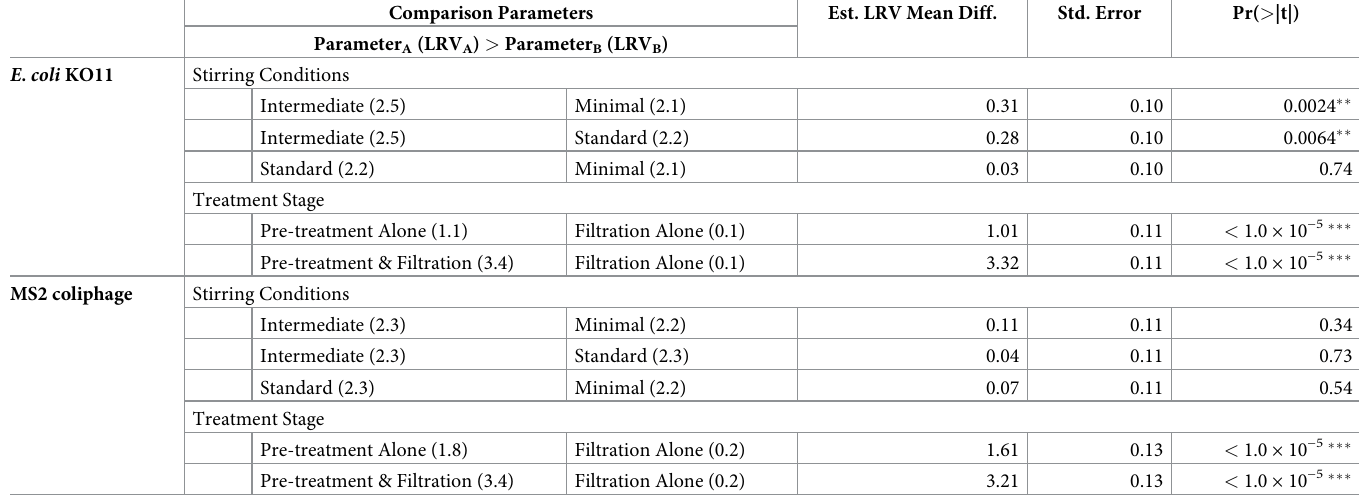
Table 1. Comparisons of estimated mean differences in average LRVs of E . coli KO11 and MS2 coliphage after controlling for selected parameters in linear regressions 1 . Comparison Parameters Est. LRV Mean